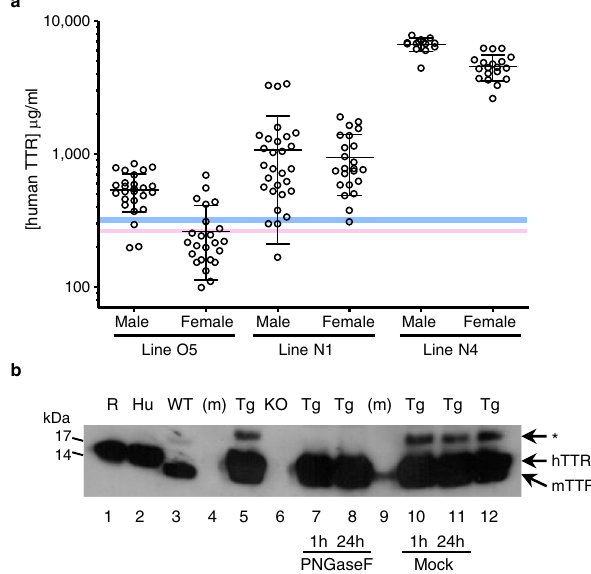
Fig. 1 Human TTR protein in the circulation of TTR S52P transgenic mice. a Human TTR concentrations in the sera of transgenic mice were measured by electroimmunoassay calibrated with isolated pure human wild-type TTR; non-transgenic mice gave no signal in this assay. Results (individual values, mean and SD) are presented for male and female transgenic mice of three independent lines that were also homozygous for a mouse ttr null allele ( n = 26, 29 and 14 for male mice of lines O5, N1 and N4, respectively, and n = 24, 23 and 19 for female mice of lines O5, N1 and N4, respectively). The reported ranges of TTR concentrations in healthy adult women and men 64 are indicated in pink and blue, respectively. b N -glycosylation of human TTR in serum of human TTR S52P transgenic mice demonstrated by western blot probed with anti-human TTR antiserum. Transgenic mouse serum was treated with PNGaseF (lanes 7 & 8) under denaturing conditions for 1 or 24 h, as indicated; lanes 10 and 11 contained serum samples treated identically except for the omission of the PNGaseF enzyme, and lanes 5 and 12 contained untreated serum. The asterisk indicates the N -glycosylated human TTR S52P protein. Other lanes contained recombinant human TTR (R), human serum (Hu), wild-type mouse serum (WT), mouse ttr knockout serum (KO) or molecular weight protein markers (m). The signal in lane 9 is a result of spillover from an adjacent lane. This experiment was not repeated. Source data are provided as a Source Data fi